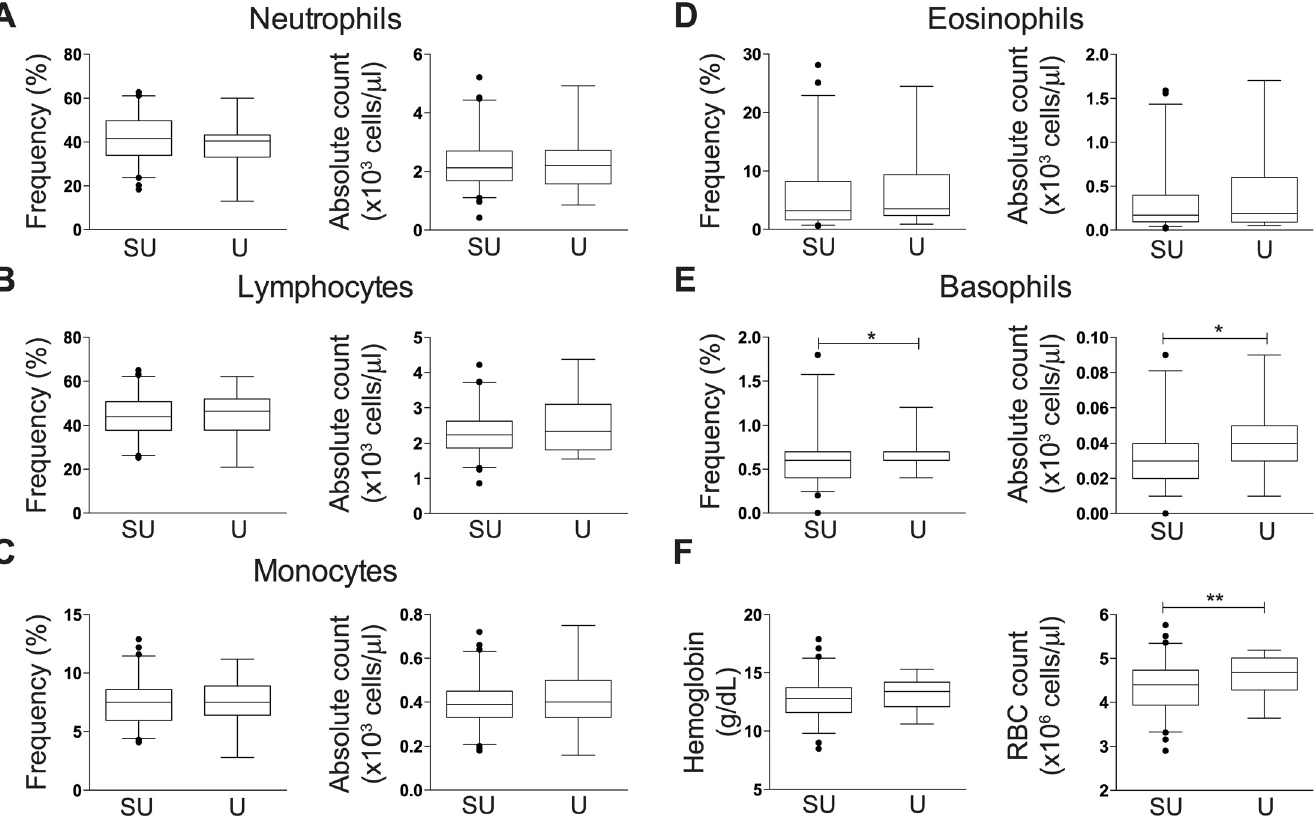
Fig 2. Comparison of hematological parameter frequency and absolute counts in females. Box and whisker plots showing median and 2.5 – 97.5 percentiles of (A) neutrophils in semi-urban blood bank donors [SU] and vaccine trial [U]; (B) eosinophils; (C) lymphocytes; (D) basophils; (E) B monocytes; and (F) hemoglobin levels and RBC counts. The non-parametric Mann Whitney U test was used to determine any statistically significant differences between cohorts; * p < 0.05, ** p < 0.01, *** p < 0.001, **** p < 0.0001.